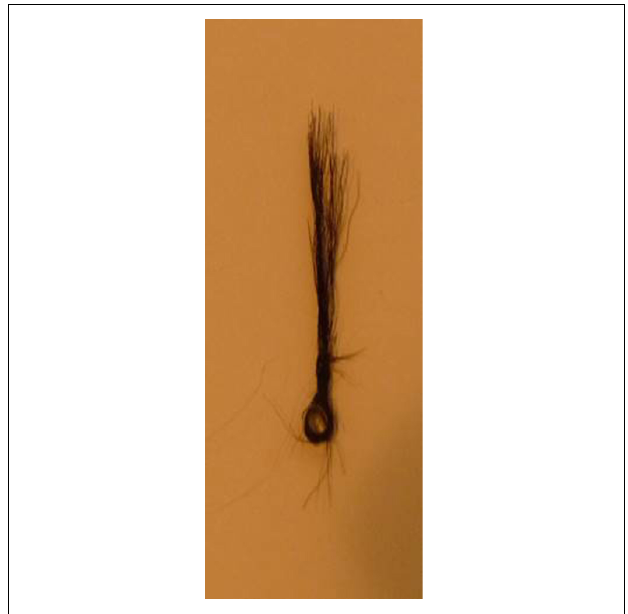
FIGURE 6 | Result of experiment to test the weight limit for the bunch of hairs. See text for complete